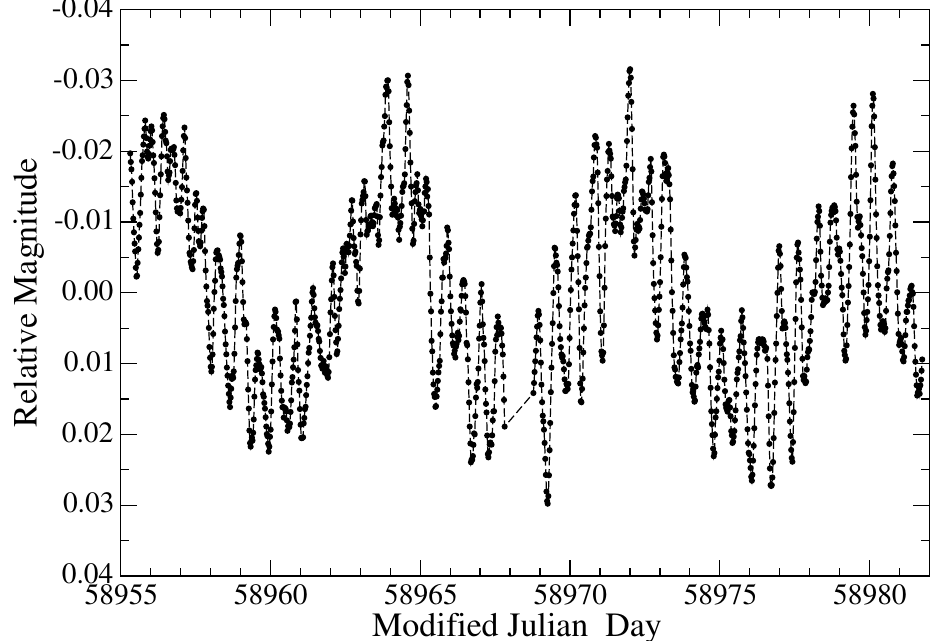
Figure 4. Section of the TESS light curve of HD 3191 during 2020 April/May covering about one and a half orbital periods. The fast intraday oscillations are suspected to be caused by stellar rotation or